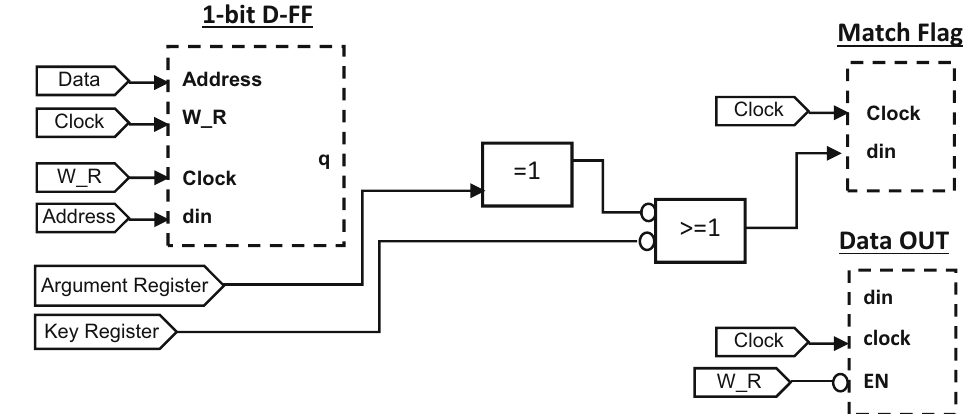
Figure 3: RTL diagram of the one - bit cell with comparison circuit in the proposed